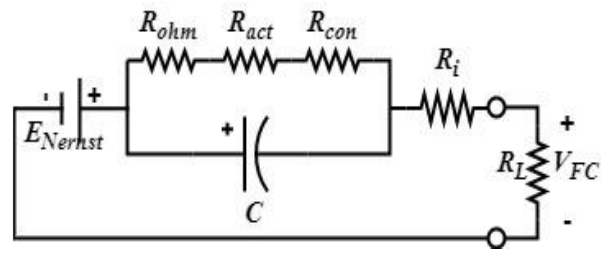
Figure 7. Used FC model.